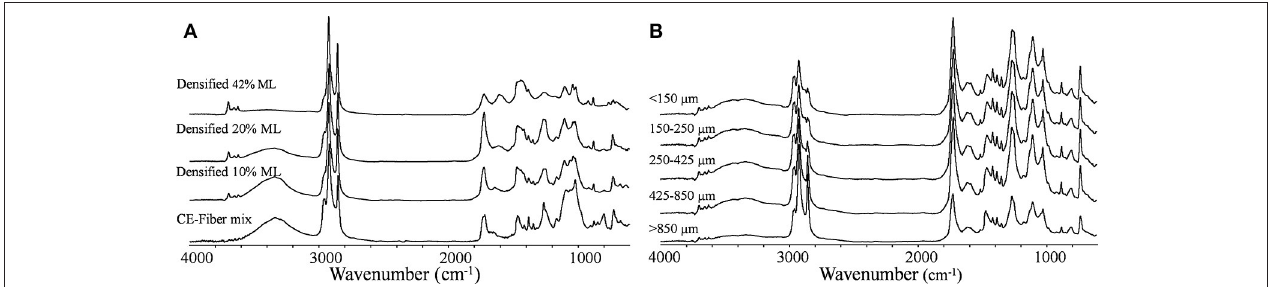
Frontiers in Energy Research |